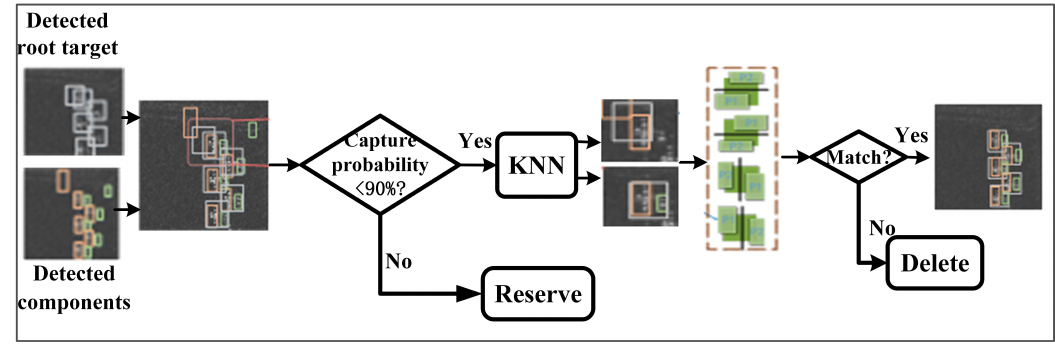
Figure 3. Discriminative constraint layer.